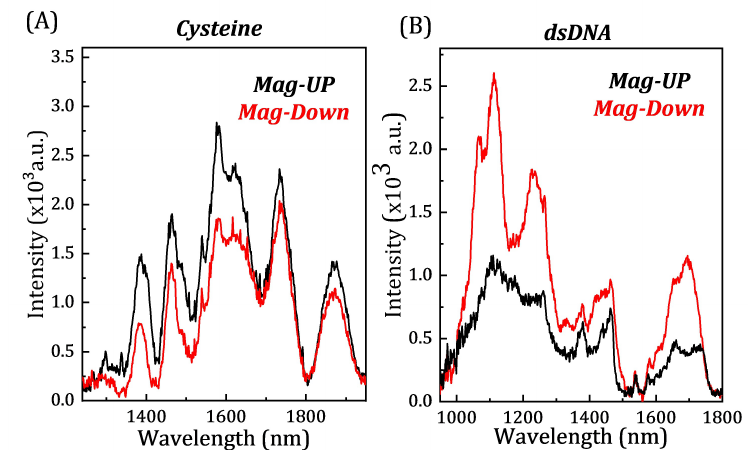
Figure 3. IR spectra of the adsorbed monolayer on the gold surface recorded in reflection mode using PMIRAS spectroscopy in magnet up (black) and magnet down (red) ( A ) L-cysteine, ( B )